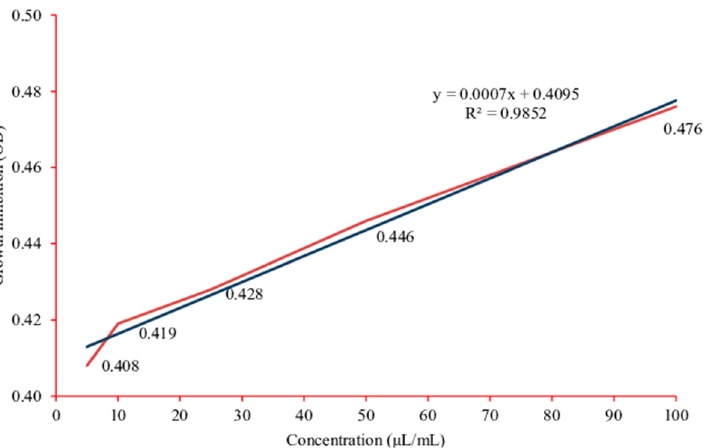
Figure 9. Growth inhibition of Edwardsiella tarda by crude Centella asiatica chloroform extract in the broth dilution assay. OD: optical density. Figure and caption reused from Purkait et al. [88]. Used under the Creative Commons License (http://creativecommons.org/licenses/by/4.0/ (accessed on 26 February 2021)).